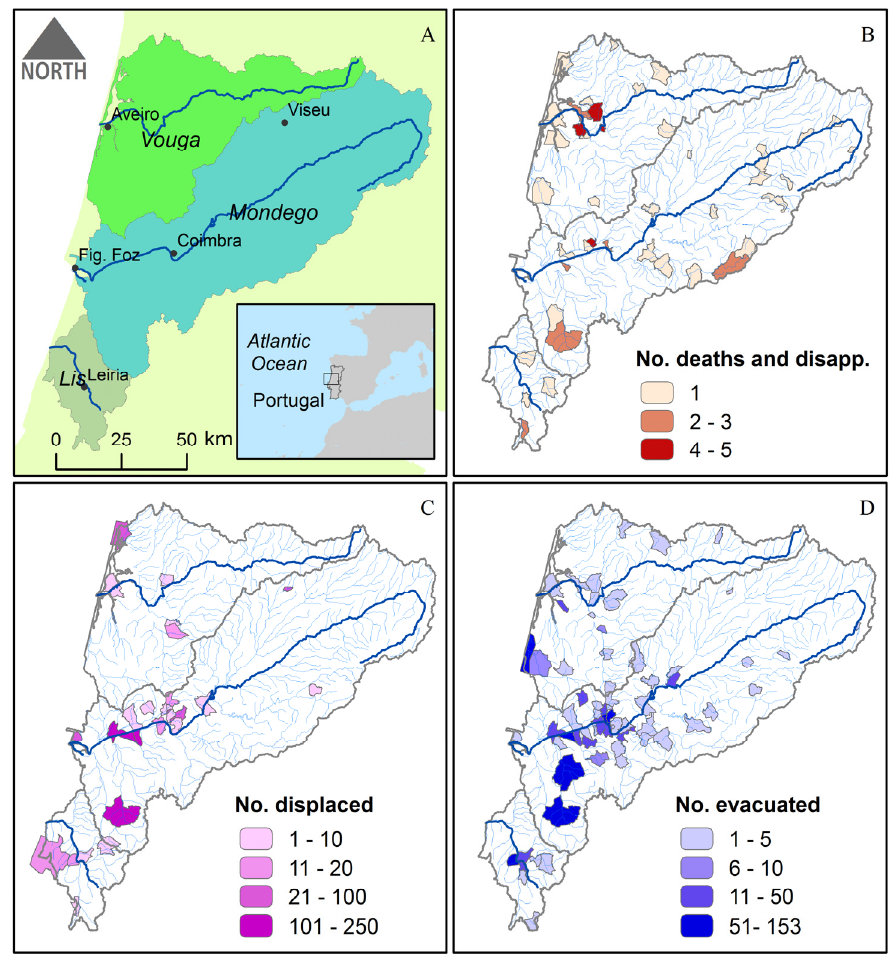
Figure 6. Relation between the main cities and rivers and the occurrences with human consequences, by parish, 1930/1931–2009/2010. ( A ) Vouga, Mondego and Lis basins;